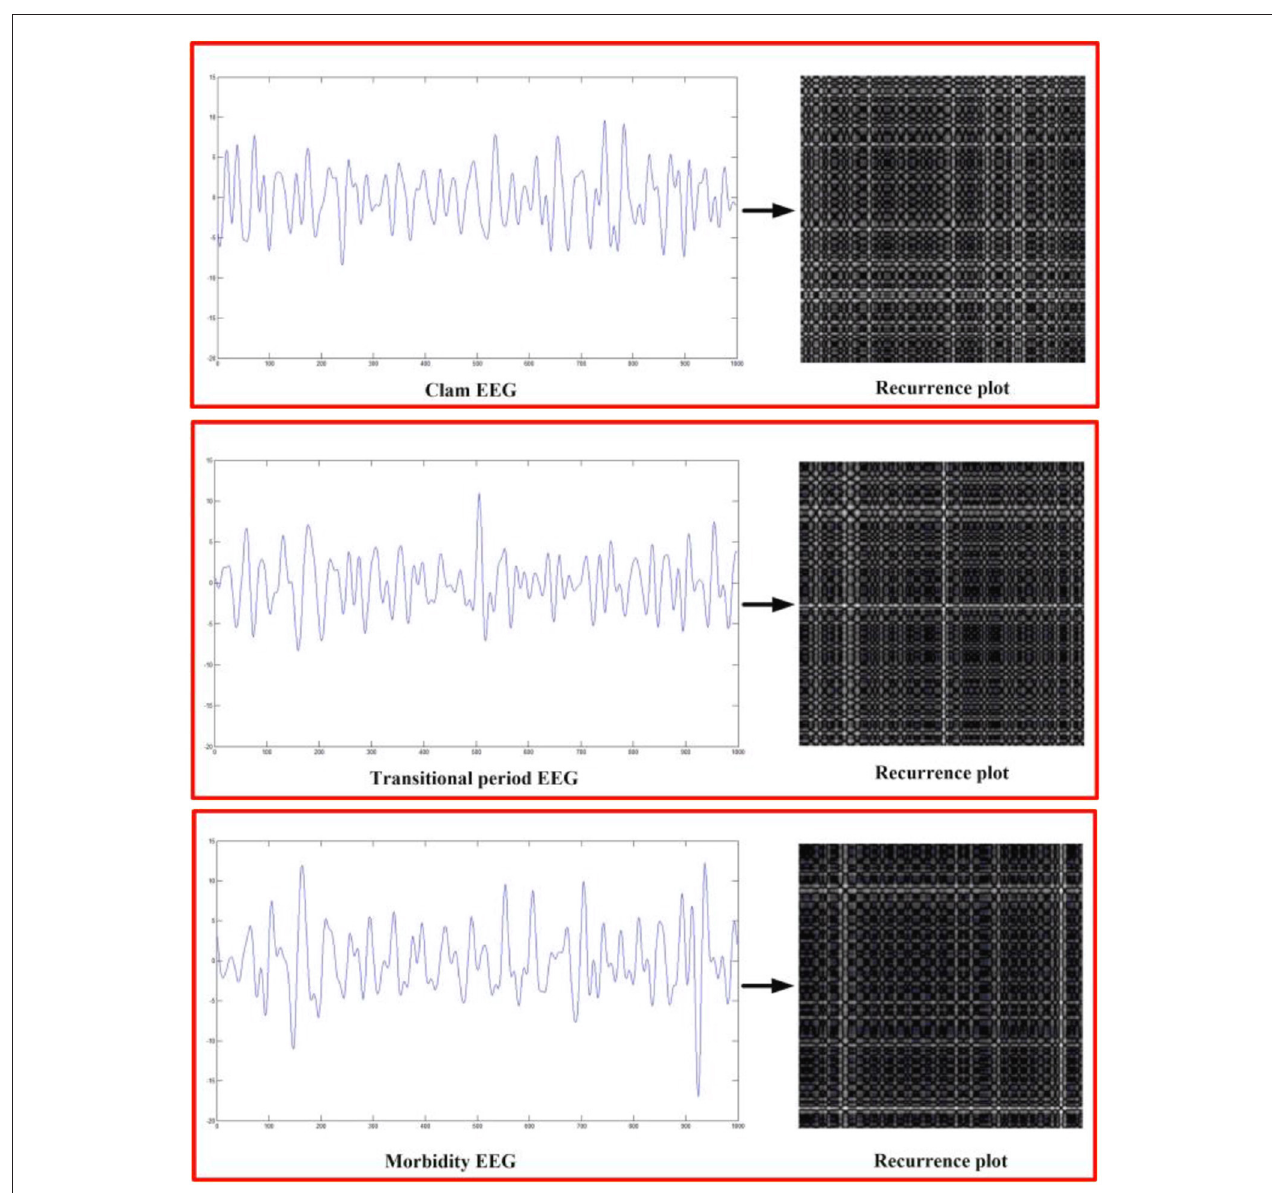
FIGURE 6 | Recurrence